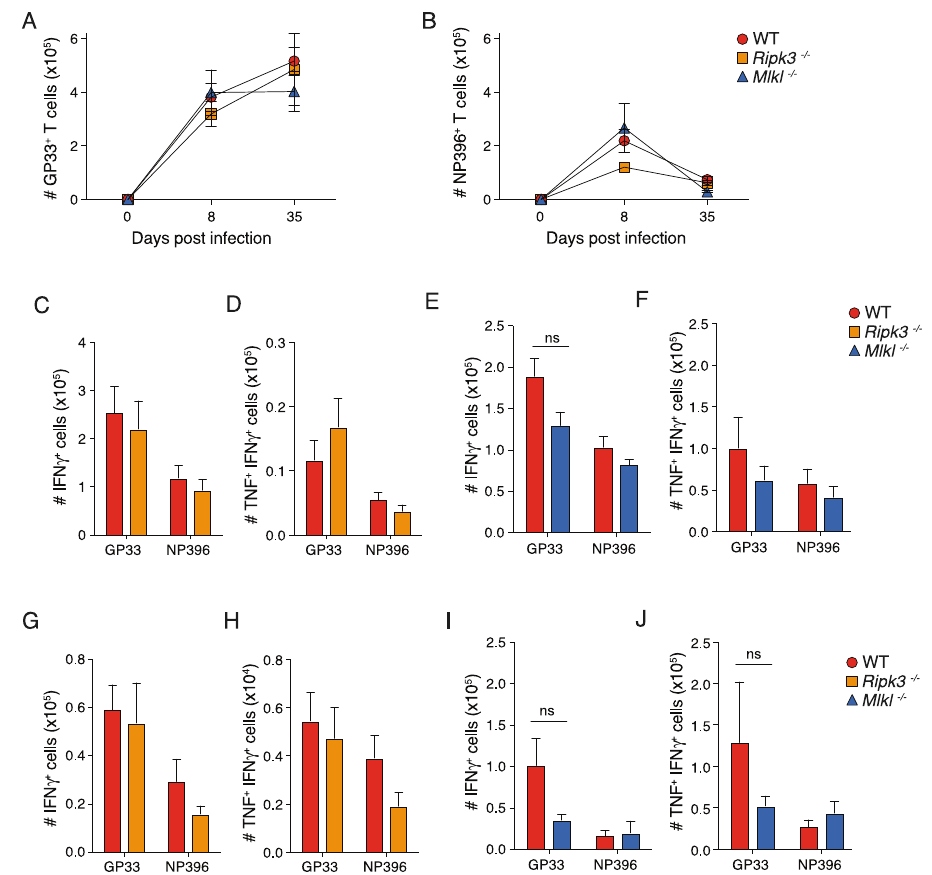
Fig. 2 Loss of RIPK3 or MLKL does not alter the expansion or attrition of virus-speci fi c CD8 + T cells during onset of chronic LCMV infection. A – B Absolute numbers of CD8 + T cells that speci fi cally recognise the LCMV epitopes ( A ) GP33 or ( B ) NP396 from the spleens of mice, with the indicated genotypes, over the course of LCMV docile infection. C – F Ex vivo cytokine production by LCMV speci fi c CD8 + T cells after restimulation with the indicated recombinant cognate LCMV peptides GP33 or NP396. CD8 + T cells were harvested from spleens of mice with the indicated genotypes at 8 days post infection with LCMV docile. G – J Ex vivo cytokine production as in ( C – F ), 35 days post infection. All data are combined from two independent experiments. Graphs showing summary data indicate mean and SEM. NS, not signi fi cant p > 0.05 (unpaired t